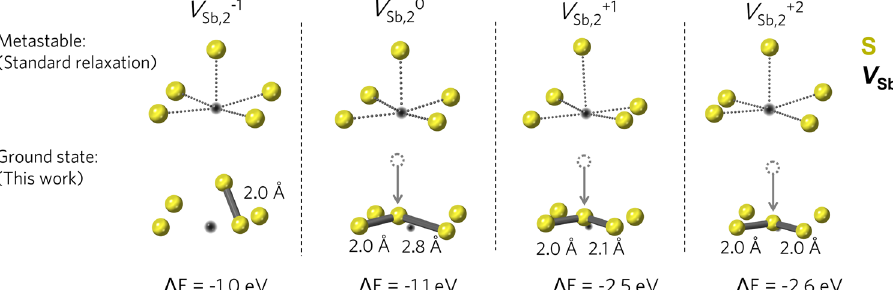
Fig. 4 Anion-anion dimer formation undergone by V (cid:1) 1 ; 0 ; þ 1 ; þ 2 in Sb 2 S 3 , where the subscript differentiates between the two symmetry Sb ; 2 inequivalent sites of Sb (shown in Supplementary Fig. 9). Similar reconstructions were observed for the other symmetry inequivalent site and in Sb 2 Se 3 . For each charge state, on the top we show the con fi guration obtained by relaxing the ideal, high-symmetry geometry and on the bottom the ground state found with our method. For the singly negative charge states, the distortion is driven by the formation of one sulfur dimer while for the neutral and positively charge states a trimer is formed. V Sb in black and S in yellow. Pseudo-bonds from the vacancy position to neighbouring S atoms are shown for the metastable con fi gurations to illustrate the coordination environment and the arrows illustrate the key displacement from the high-symmetry structure.